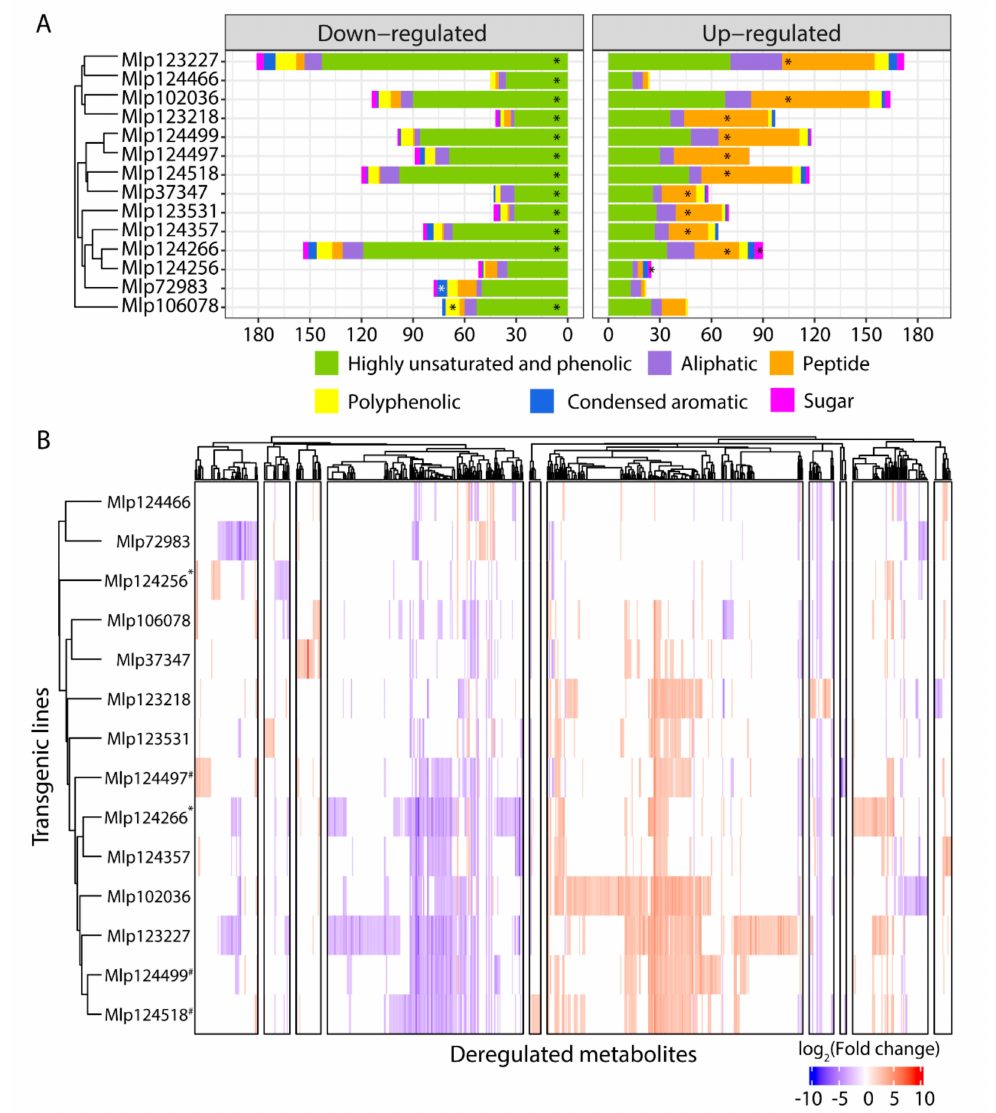
Figure 6. ( A ) Metabolites down-regulated ( left ) are enriched in highly unsaturated and phenolic compounds while peptides are over-represented among those up-regulated ( right ). Samples were analyzed in negative mode and relative abundance of metabolites in samples was compared to that in the control plants. Estimated molecular formulas were separated in six categories: highly unsaturated and phenolic (green), aliphatic (purple), peptide (orange), polyphenolic (yellow), condensed aromatic (blue), and sugar (pink). ( B ) Transgenic lines expressing candidate effectors with no similarity in amino acid sequence have correlated patterns of metabolite deregulation. Both metabolites and transgenic lines were clustered using Pearson’s correlation. * indicates transgenic lines with CEs from the CPG5464 family; # indicates transgenic lines with CEs from the CPGH1 family. The underlying data for this figure can be found in the study by dos Santos et al.